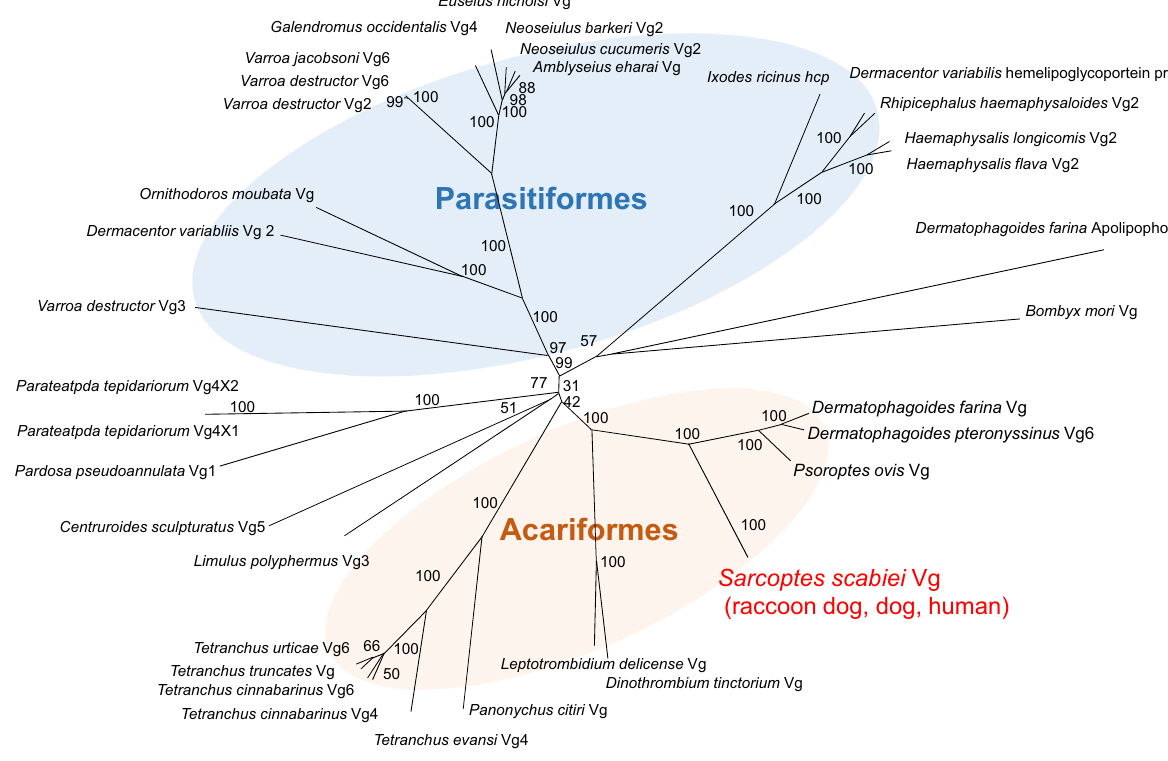
Figure 5. A molecular phylogenetic tree of arthropod vitellogenin was constructed. The DDBJ/GenBank/ EMBL accession numbers are follows: IACW01000323 ( Sarcoptes scabiei var nyctereutis Vg like protein), KPM02263.1 ( Sarcoptes scabiei var canis Vg like protein), Creation by scaffold41081_cov61 and 6362_cov109 ( Sarcoptes scabiei var hominis Vg like protein), XP_027195573.1 ( Dermatophagoides pteronyssinus